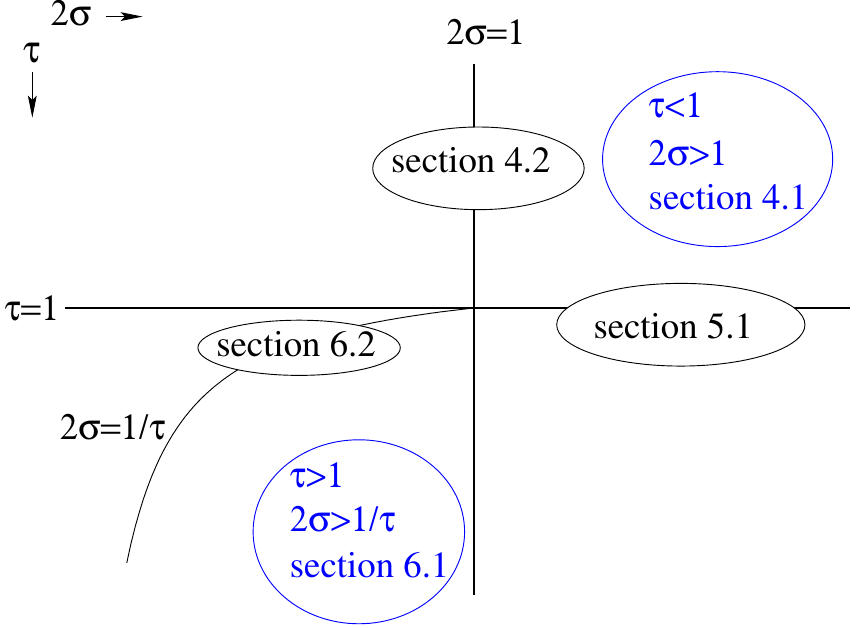
Figure 5. Regions of parameter space explored in this paper, with the respective subsections of the T increases in the downward direction paper indicated for each. The temperature parameter τ = d ζ 2 (as it generally does on the Earth), and the parameter which often controls the exponent of the power law degree distribution, 2 σ , increases to the right. Since larger σ generally means faster fall off of the degree distribution, we can imagine fat or long tails to the left, and more truncated tails to the right. We can think of increased temperature as promoting noise which shifts the model in the direction of a uniform distribution on graphs. The two ‘generic’ regions in blue both manifest power law degree distributions. The three other ‘measure zero’ regions do not yield non-trivial degree distributions at finite degree, using the growth rate of R H with N that we have chosen for them. Only the upper right region τ < 1 and 2 σ > 1 has appeared in the previous